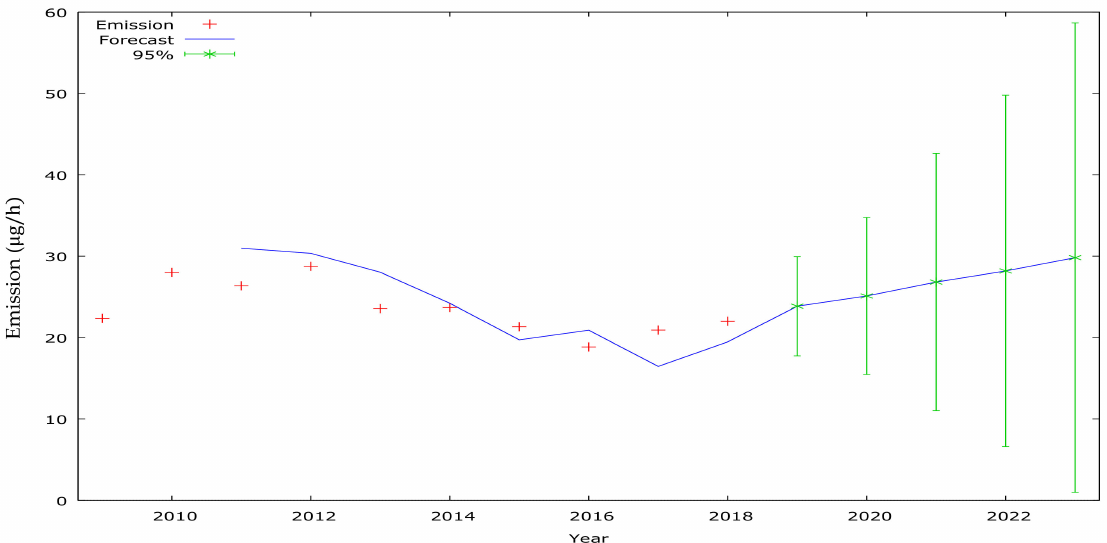
Figure 5. Graph of the dependence of the average PM 2.5 emission in µ g/h in individual years together with the values forecasted by the ARIMA model (1,2,0), (averaging time 1 h, average value), zone code PL1401. Source: Own elaboration, based on data from Chief Inspectorate of Environmental Protection [37].